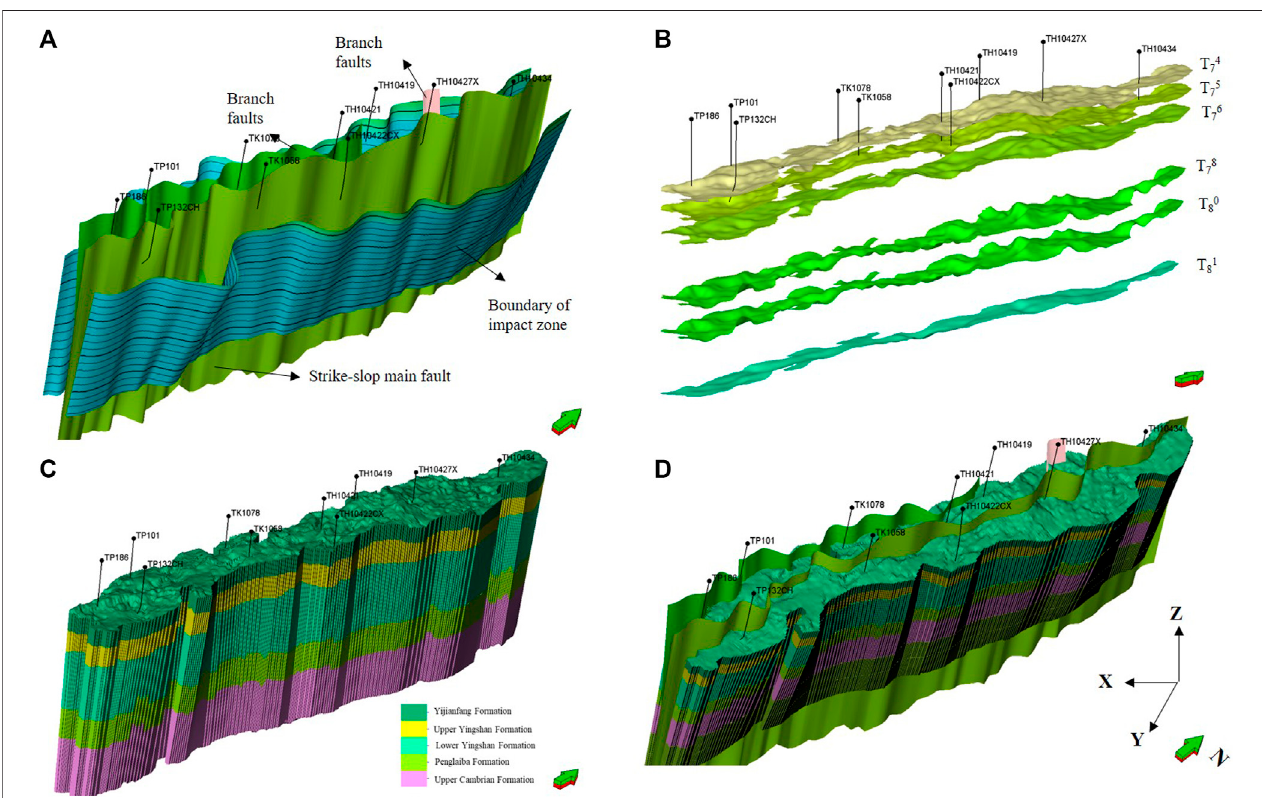
FIGURE 5 | Strike-slip fault zone model in TP12CX units. (A) Main and branch faults interpretation; (B) The main target horizon; (C) Stratigraphic model; (D) Fault impact zone model Remarks: T 74 : Top of the Yijianfang Formation, T 76 : Top of the lower member of the Yingshan Formation, T 78 : Top of the Penglaiba Formation, T 80 : Top of the Cambrian, T 90 : Bottom of the Lower